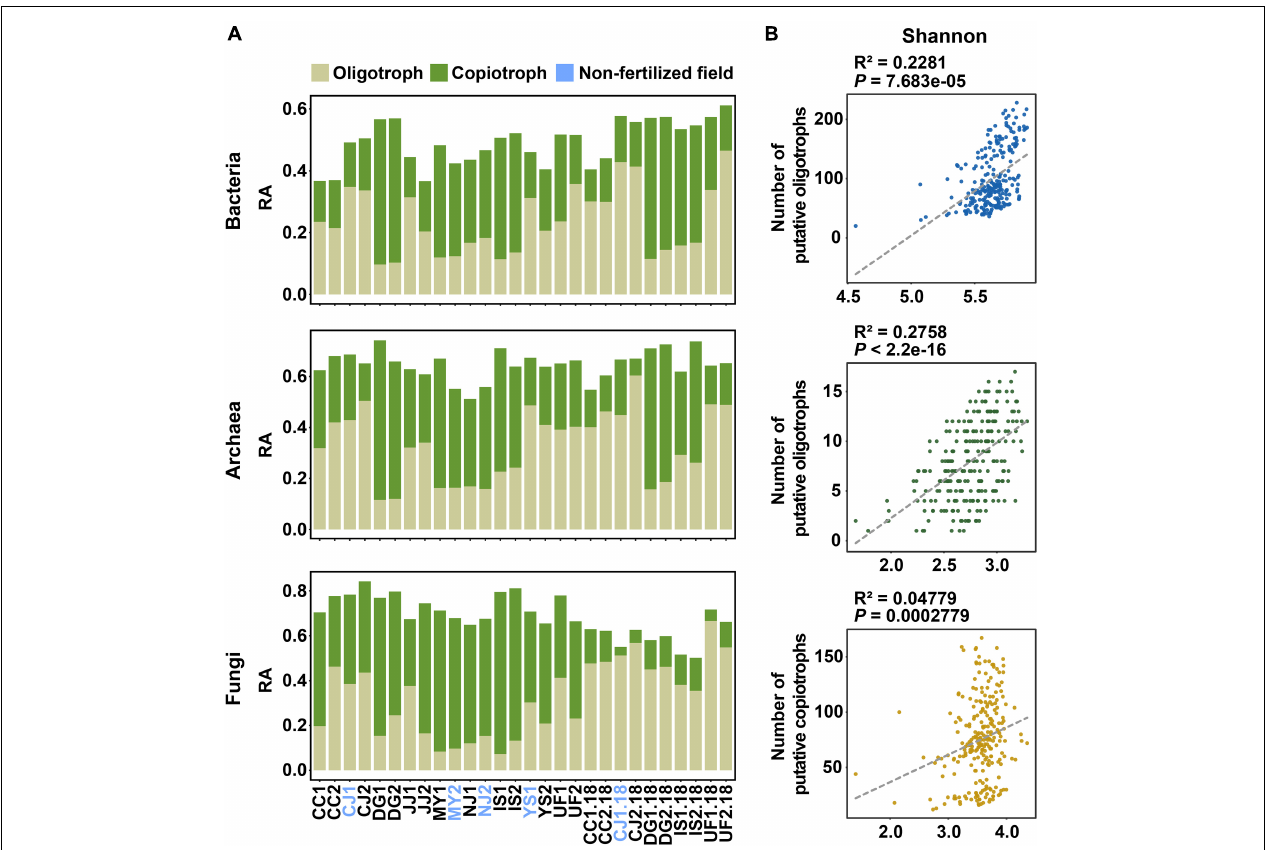
FIGURE 3 | Distributions of putative oligotrophs and copiotrophs in bacterial, archaeal, and fungal communities and their relationships with microbial diversity. (A) Cumulative relative abundances of putative oligotrophs and copiotrophs in rice paddy fields. Putative oligotrophs and copiotrophs were classified based on the correlations between OTU abundances and SOM or TN content. Putative oligotrophic OTUs were defined as OTUs that had a significant negative correlation with SOM or TN. By contrast, putative copiotrophs were identified as OTUs with a significant positive correlation to SOM or TN. Colors indicate trophic lifestyles (light green, oligotrophy; dark green, copiotrophy). (B) Relationship between the Shannon index and the number of putative oligotrophs or copiotrophs in bacterial (upper panel), archaeal (middle panel), and fungal (bottom panel) communities. The relationships were estimated using linear regression. Dashed lines indicate trend lines for each plot. RA, relative